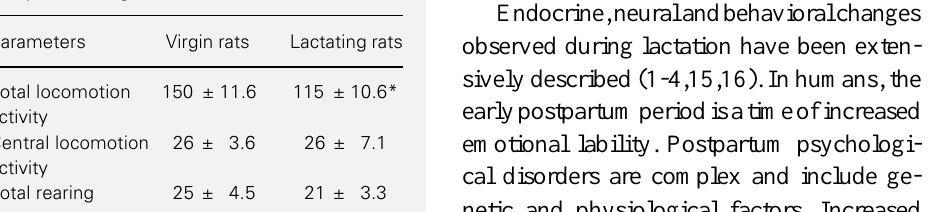
Table 1 - Open-field test behavior of age-matched female virgin (N = 10) and 6th day postpartum lactating (N = 9)